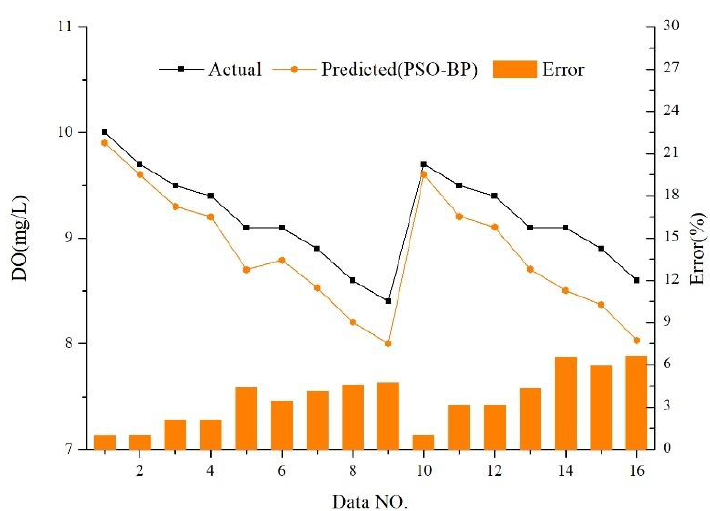
Figure 11. The predicted PSO-BP value and its error percentage.